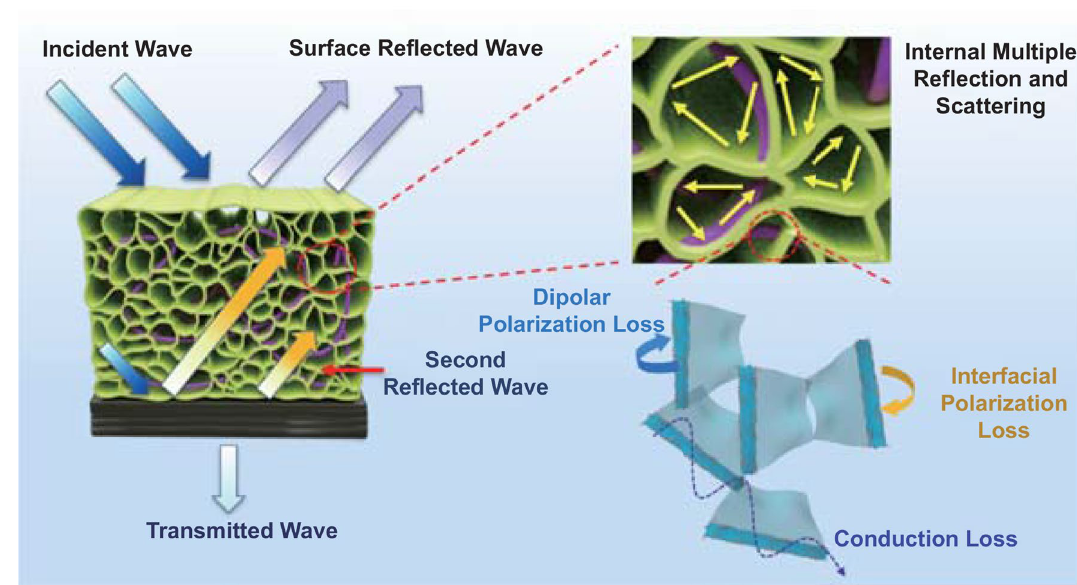
Fig. 7 Schematic illustration of EM wave dissipation in the layered foam/film PVDF